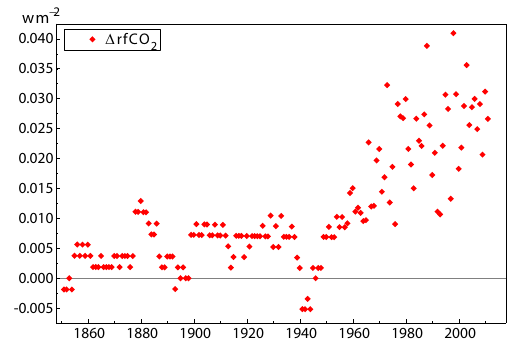
Fig. 3. Time series of the first differences of rfCO 2 from Beenstock et al. (2012).